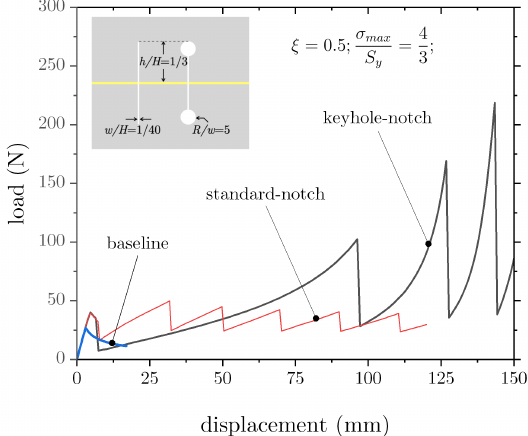
Figure 11. Effect of notch geometry on the load–displacement response of DCB